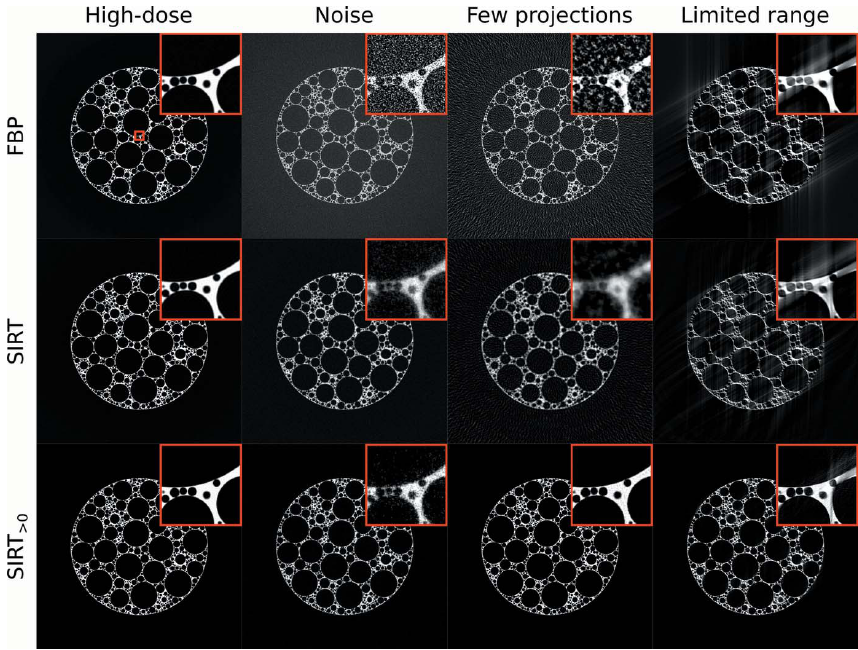
Figure 8 Reconstructed images of the central slice of a foam phantom, for various simulated experimental conditions (see Table 1). Given are results for FBP, SIRT, and SIRTwith an additional nonnegativity constraint (SIRT >0 ).